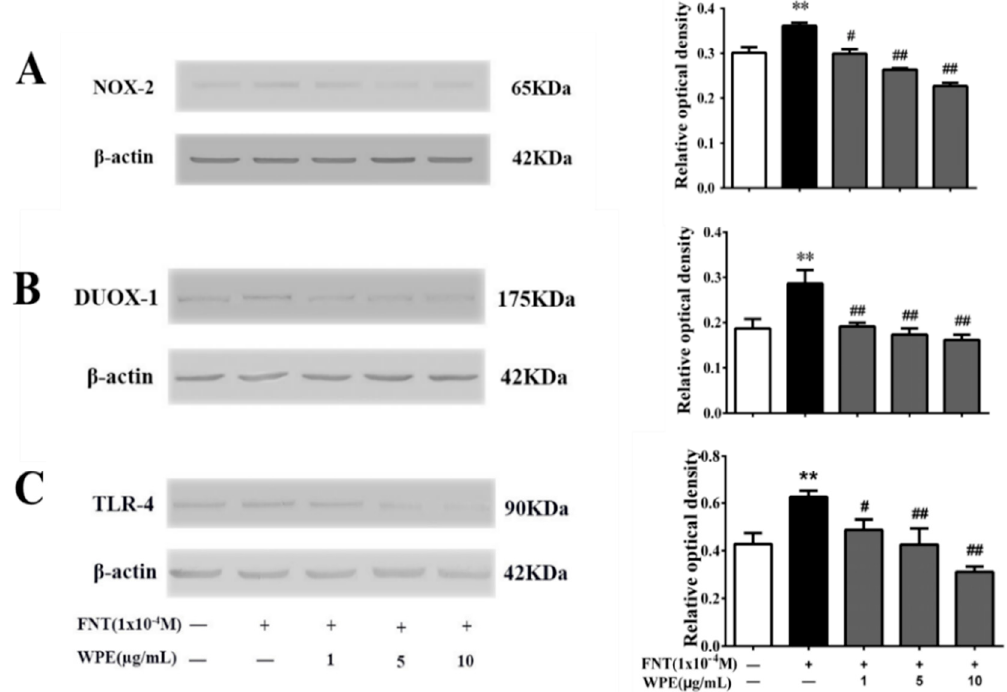
Figure 7. Effects of WPE on the expression of nicotinamide adenine dinucleotide phosphate (NADPH) oxidase and TLR-4 in Splenic T Cells exposed to FNT in the presence of Con A (5 µ g/mL). The expression of ( A ) NOX-2, ( B ) DUOX-1 and ( C ) TLR-4 in splenic T cells were measured using western blotting. Results shown are means ± SD of three separate experiments. ** p < 0.01 vs. untreated control; # p < 0.05 or ## p < 0.01 vs. FNT treatment.